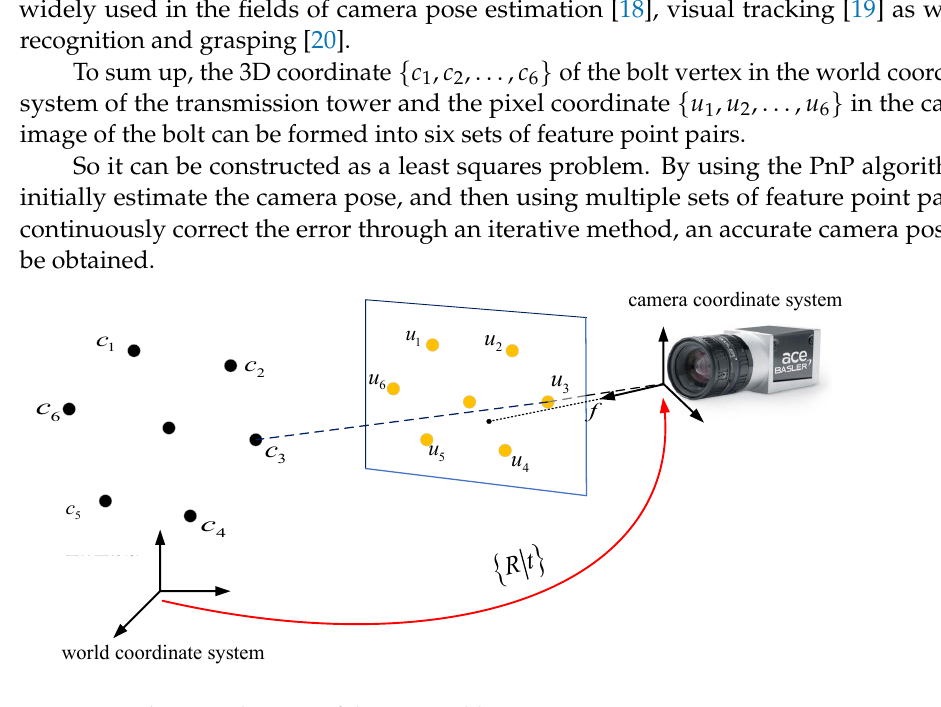
Figure 11. Schematic diagram of the PnP